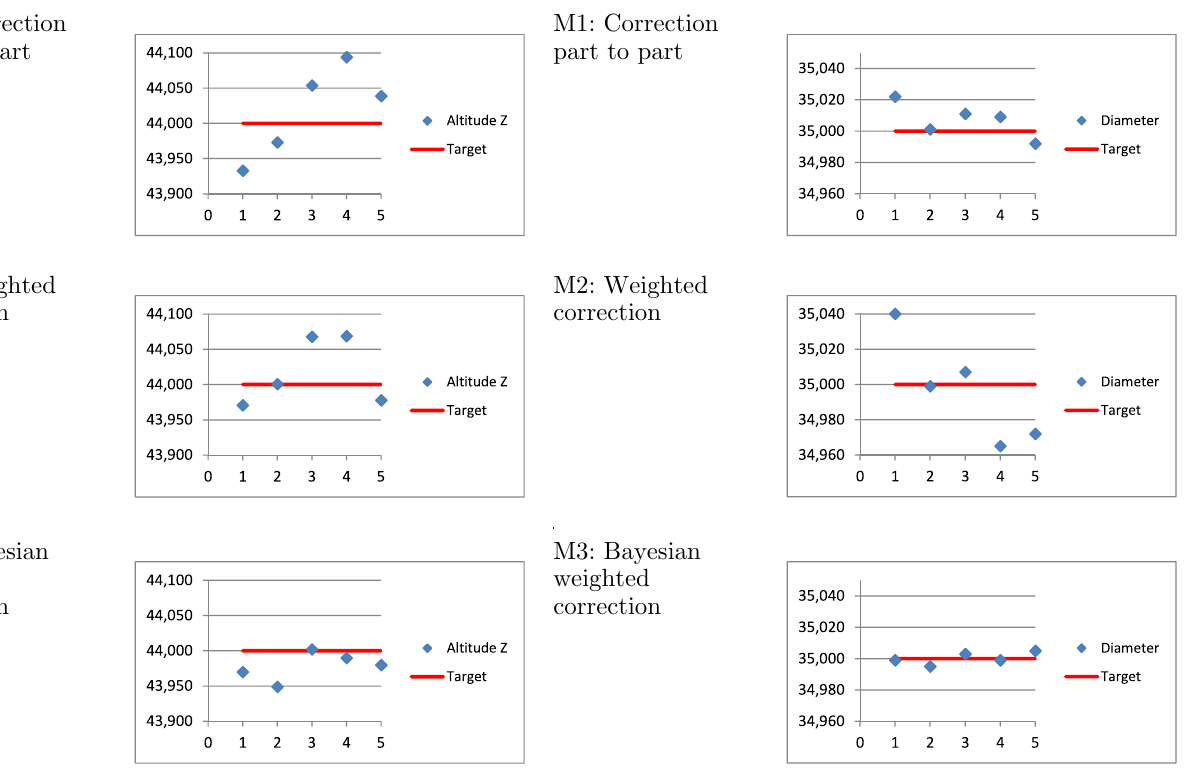
Table 7 Control of the depth ( Z ) of the circular groove. Table 8 Piloting the diameter of the circular